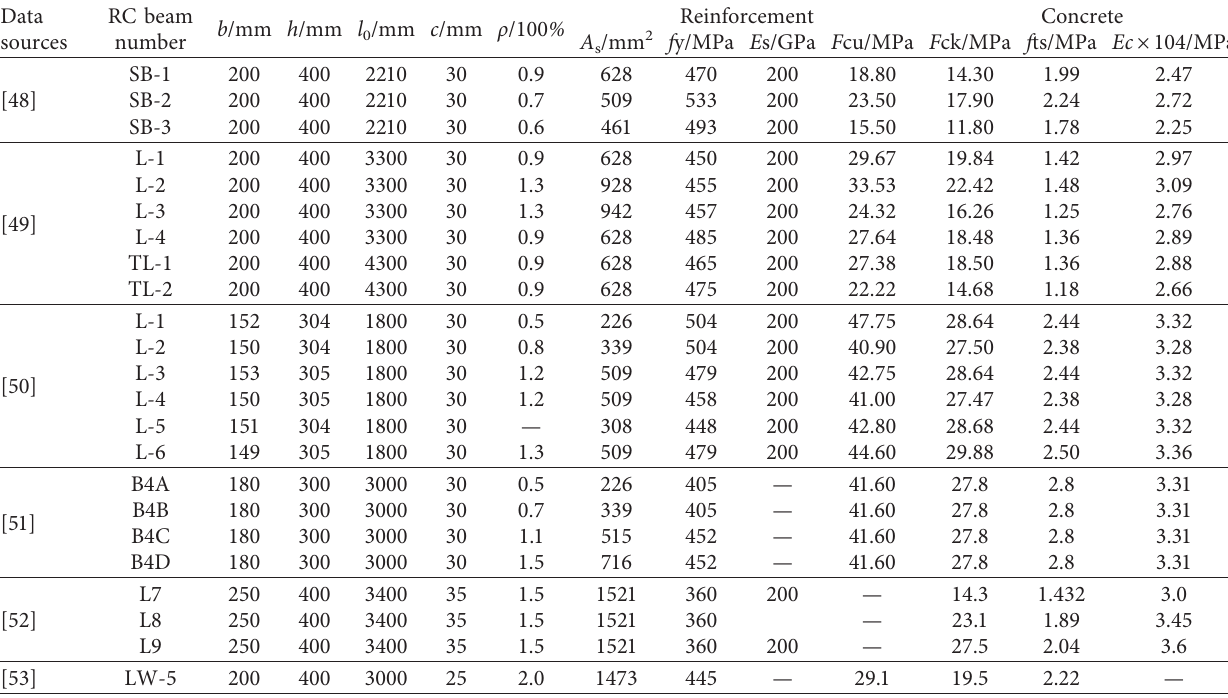
Table 6: Details of beams with 400MPa steel